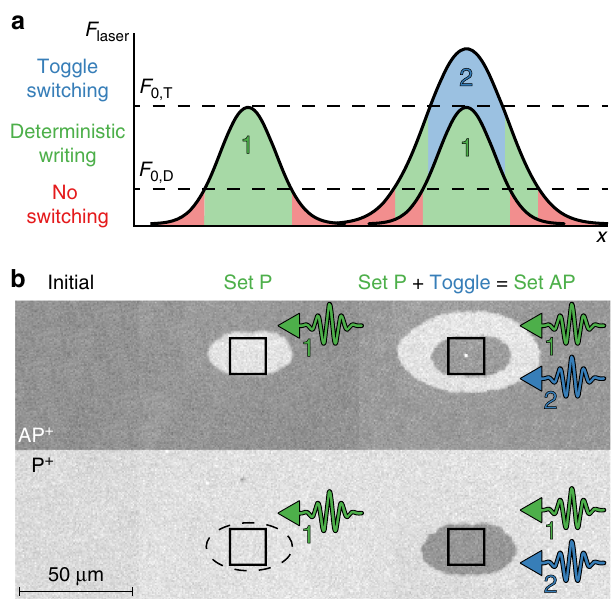
Fig. 2 Controllably writing both states of the free layer. a Sketch of the scheme used to set the free layer magnetization parallel to the reference layer with one fs laser pulse (left) or antiparallel with two pulses (right). b Kerr microscopy images showing the deterministic writing of both a P and AP state (black squares) regardless of the initial state of the switching